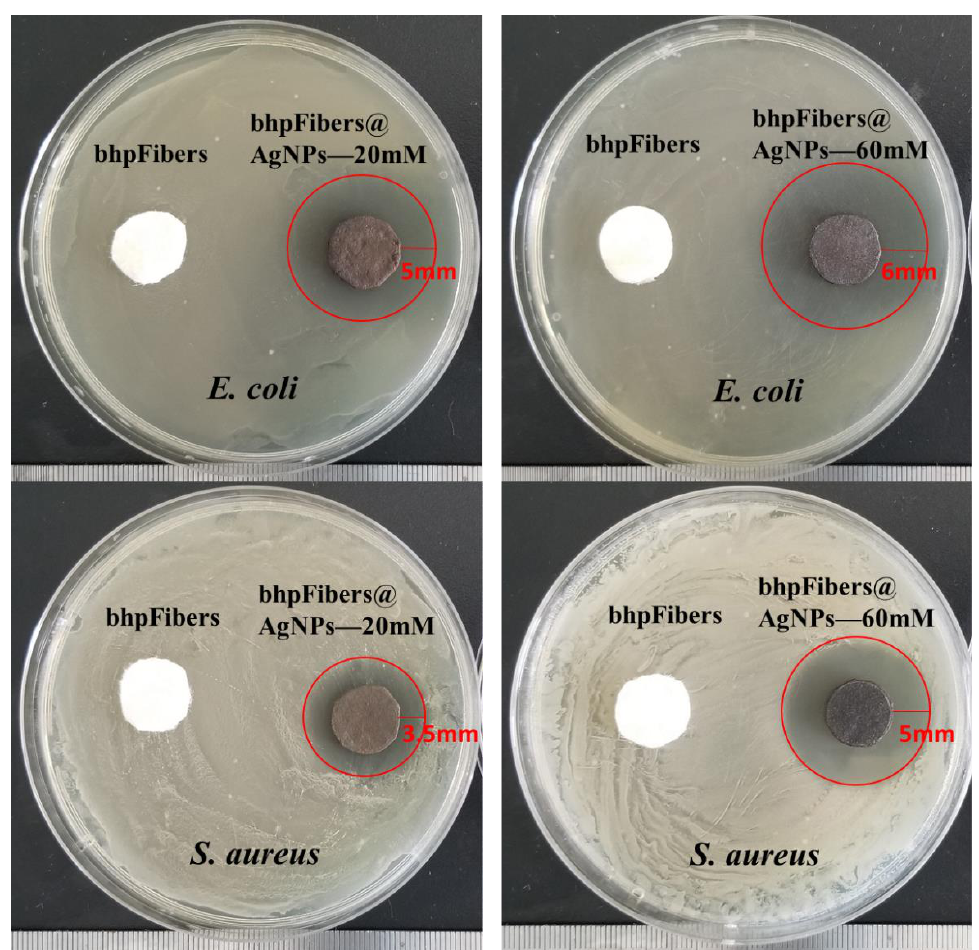
Figure 6. The antibacterial property of bhpFibers and bhpFibers@AgNP-based paper generated using aq. AgNO 3 solutions of concentrations 20 and 60 mM, respectively, against E. coli and S. aureus .